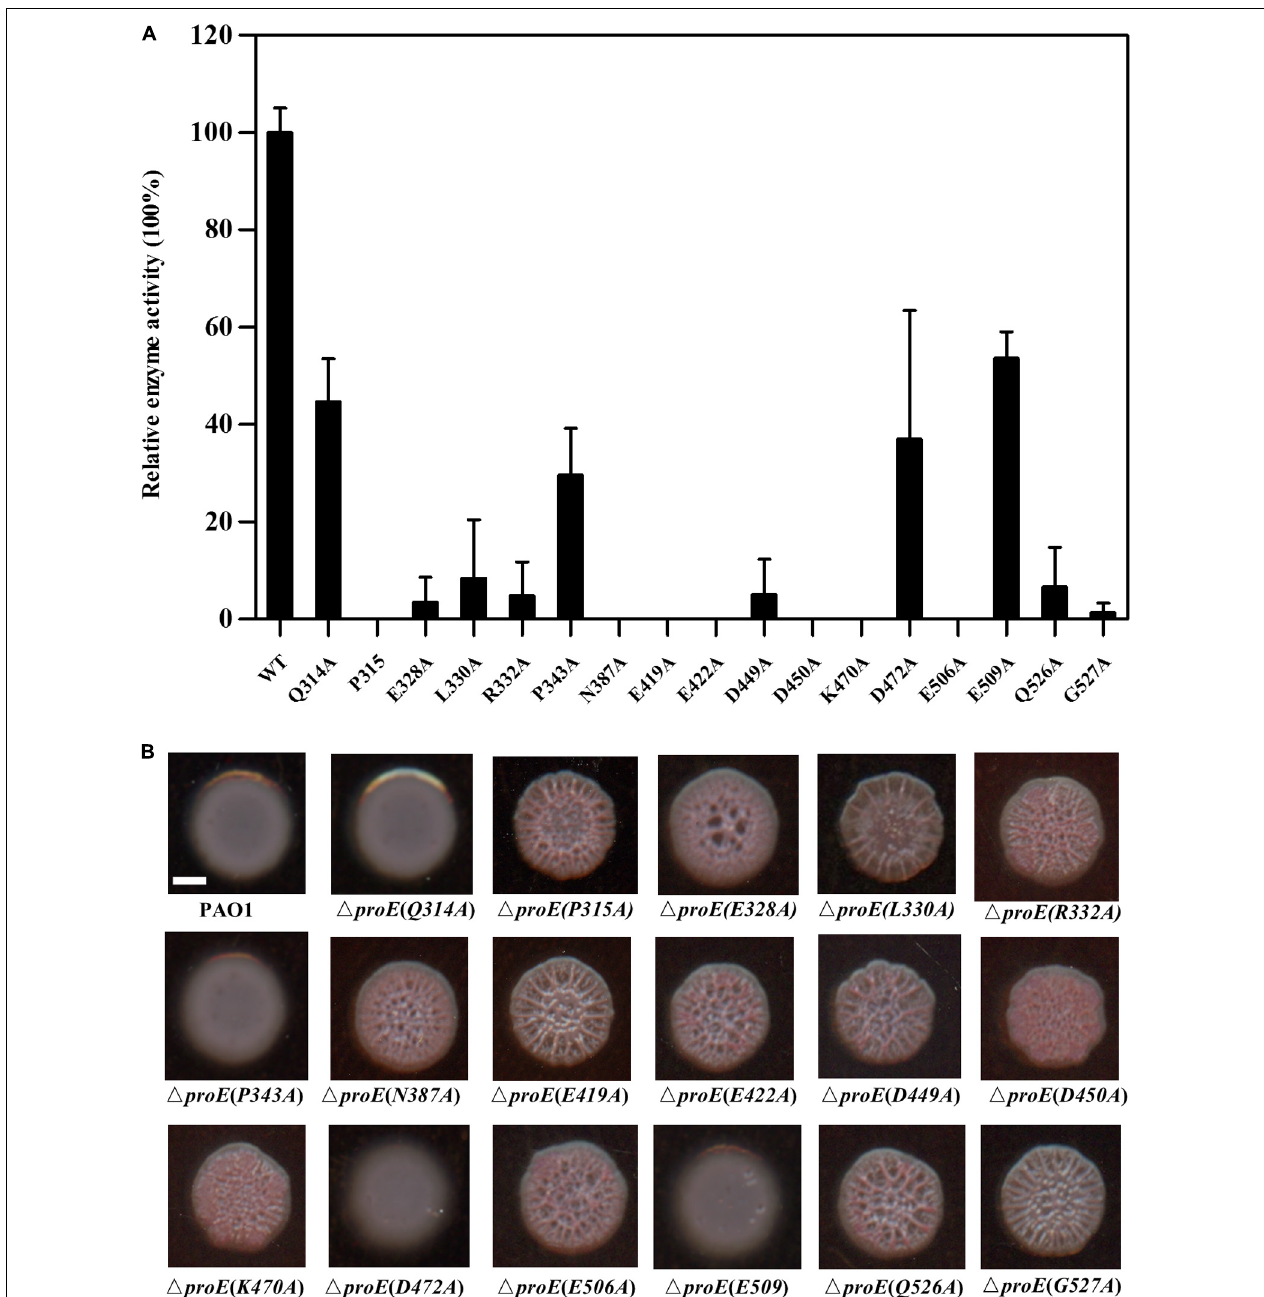
FIGURE 5 | Functional analysis of the conserved residues of EAL domain of ProE. (A) After site-directed mutagenesis, the enzyme activity of mutant proteins were analyzed. The data are means of three replicates and error bars indicate standard deviation. (B) Effect of conserved residues on the colony morphology of P. aeruginosa strain PAO1 and its derivatives on Congo-Red plates. The native proE gene is deleted, and the proE alleles are according to complementation of mutated pBBR1-MCS5- proE into (cid:49) proE. Scale bar = 2 mm.